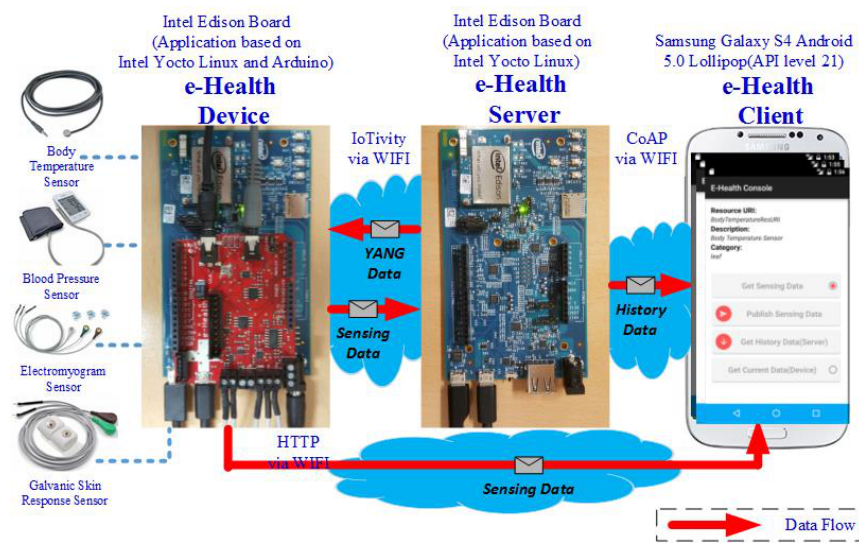
Figure 7. Prototype implementation of the proposed e-Health system.